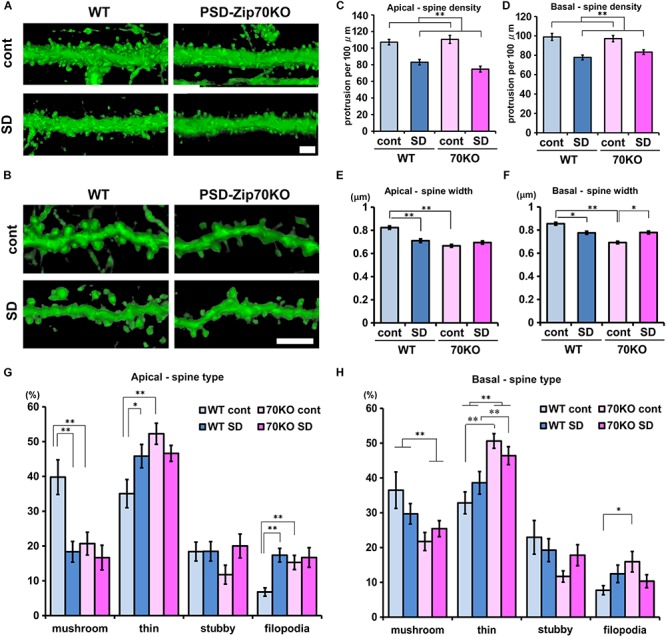
PSD-Zip70 deficiency and SD stress reduce dendritic spine size in the mPFC. Analysis of dendritic spine morphology in GFP-expressing pyramidal neurons in the mPFC of WT and PSD-Zip70KO mice which were crossed with Thy1-GFP-M mice. (A,B) Representative images of spines in apical (A) and basal (B) dendrites in the dorsal mPFC (ACC and PrLC). Confocal images were volume rendered by Imaris software. Scale bars, 5 μm. Quantification of spine density (C,D) and width (E,F) in apical and basal dendrites in the mPFC, respectively (mice, WT-control, n = 6; WT-SD, n = 5; Zip70KO-control, n = 6; Zip70KO-SD, n = 7). Apical density: spines, WT-control, n = 1126; WT-SD, n = 1003; Zip70KO-control, n = 1033; Zip70KO-SD, n = 1060 (Fgene(1,130) = 0.4151, P < 0.001, Fstress(1,130) = 59.7792, P < 0.001, Fgene × stress(1,130) = 2.2473, P = 0.1363). Basal density: spines, WT-control, n = 898; WT-SD, n = 846; Zip70KO-control, n = 1359; Zip70KO-SD, n = 916) (Fgene(1,183) = 3889, P = 0.5337, Fstress(1,183) = 34.1167, P < 0.001, Fgene × stress(1,183) = 1.4814, P = 0.2251). Apical width: spines, WT-control, n = 509; WT-SD, n = 532; Zip70KO-control, n = 523; Zip70KO-SD, n = 503 (Fgene(1,2066) = 36.9111, P < 0.001, Fstress(1,2066) = 8.9034, P < 0.001, Fgene × stress(1,2066) = 24.8779, P < 0.001). Basal width: spines, WT-control, n = 636; WT-SD, n = 689; Zip70KO-control, n = 739; Zip70KO-SD, n = 659). (Fgene(1,2722) = 41.7892, P < 0.001, Fstress(1,2722) = 0.1949, P = 0.7460, Fgene × stress(1,2722) = 44.7480, P < 0.001). (G,H) Classification of the spine morphology of apical and basal dendrites, respectively. Apical, mushroom, Fgene(1,57) = 7.2497, P = 0.0094, Fstress(1,57) = 10.8932, P = 0.0017, Fgene × stress(1,57) = 5.0918, P = 0.0281; thin, Fgene(1,57) = 7.3242, P = 0.0091, Fstress(1,57) = 0.5965, P = 0.4433, Fgene × stress(1,57) = 6.0822, P = 0.0169; stubby, Fgene(1,57) = 0.7306, P = 0.3965, Fstress(1,57) = 1.9601, P = 0.1672, Fgene × stress(1,57) = 1.8869, P = 0.1652; filopodia, Fgene(1,57) = 3.4620, P = 0.0682, Fstress(1,57) = 8.1036, P = 0.0062, Fgene × stress(1,57) = 4.7247, P = 0.0341) Basal, mushroom, Fgene(1,63) = 8.6220, P = 0.0047, Fstress(1,63) = 0.2296, P = 0.6336, Fgene × stress(1,63) = 2.6216, P = 0.1107; thin, Fgene(1,63) = 44.2931, P < 0.001, Fstress(1,63) = 4.8613, P = 0.0313, Fgene × stress(1,63) = 0.0044, P = 0.9474; stubby, Fgene(1,63) = 3.9140, P = 0.0525, Fstress(1,63) = 0.1436, P = 0.7051, Fgene ×stress(1,63) = 2,3429, P = 0.1311, filopodia, Fgene(1,63) = 1.8567, P = 0.1781, Fstress(1,63) = 0.0390, P = 0.8442, Fgene × stress(1,63) = 5.3032, P = 0.0248). All data are presented as mean ± S.E.M. ∗P < 0.05, ∗∗P < 0.01; n.s., not significant.